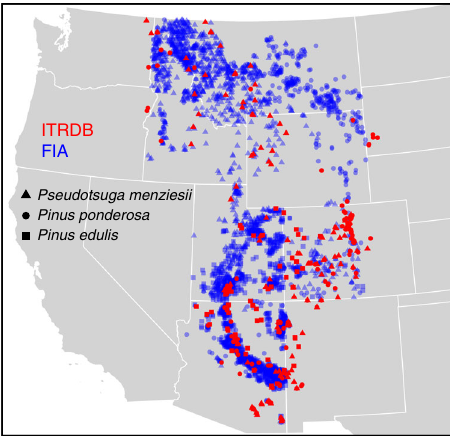
Figure 2b) — which may re fl ect sampling aimed at snowpack